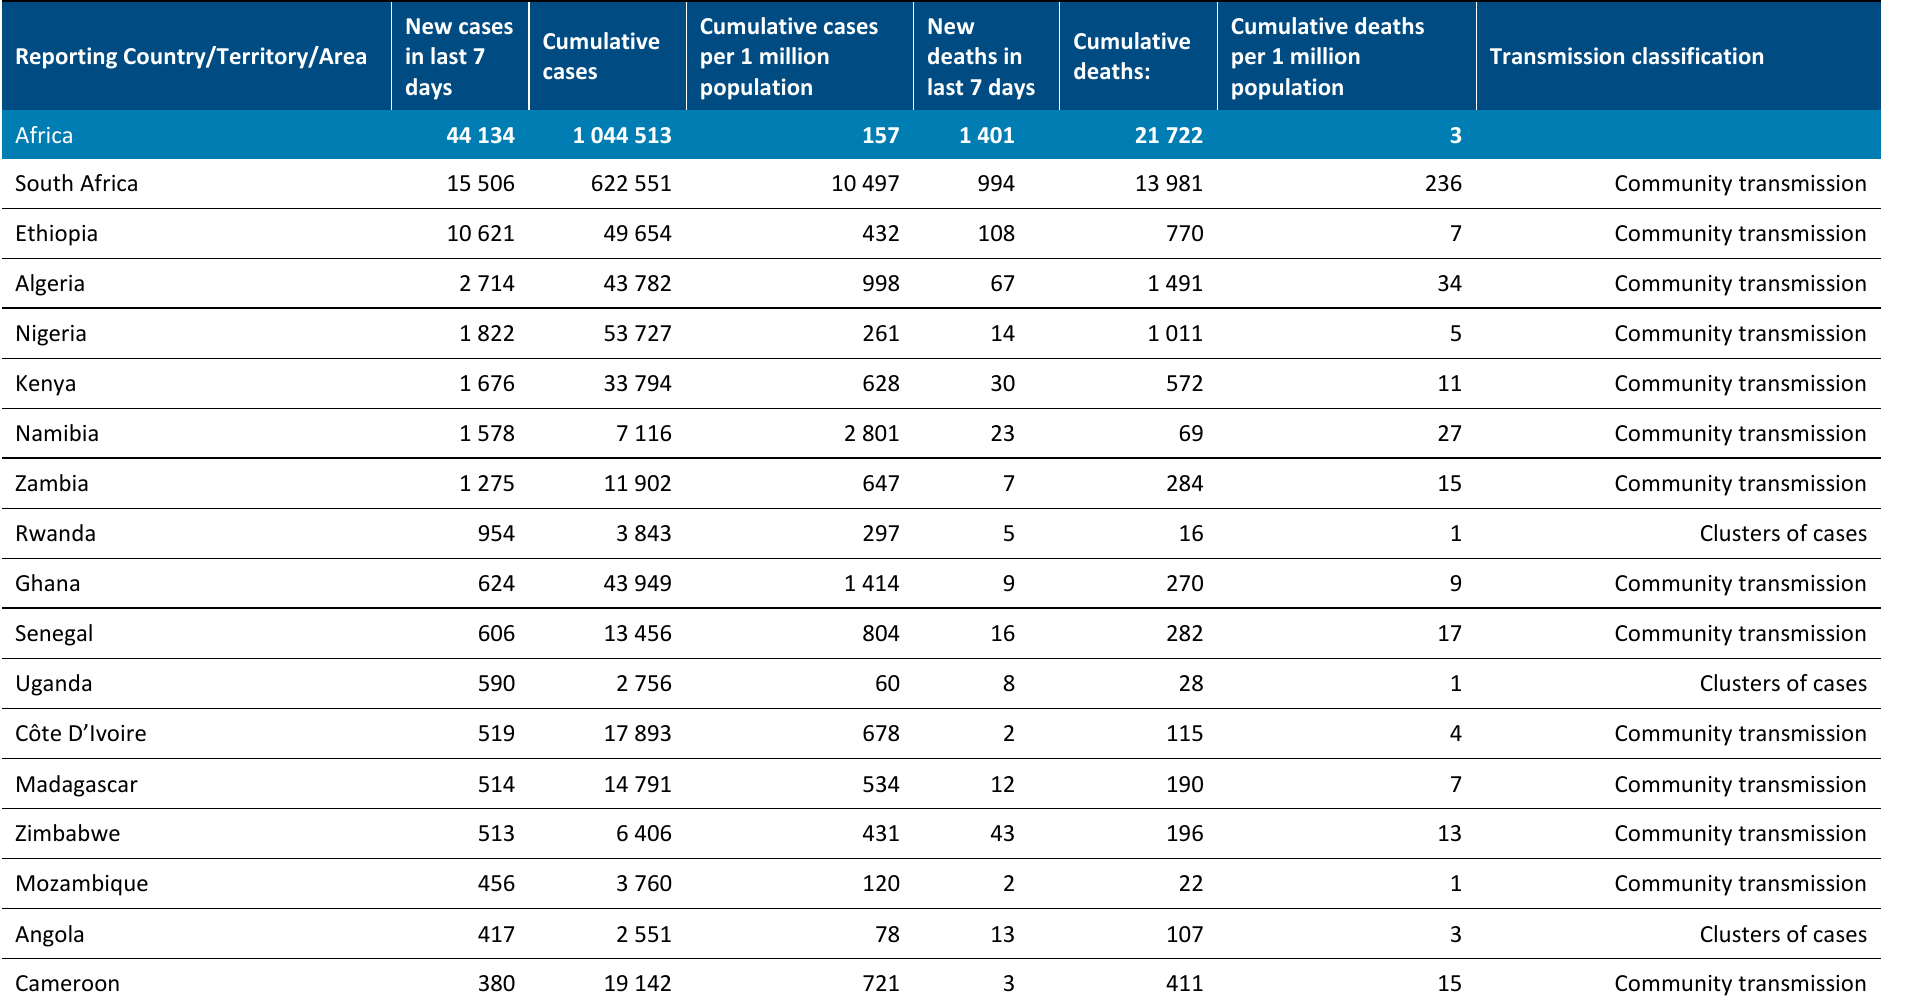
Table 2. Number of COVID-19 confirmed cases and deaths reported in the last seven days by countries, territories and areas, African Region, data as of 30 August 2020** Reporting